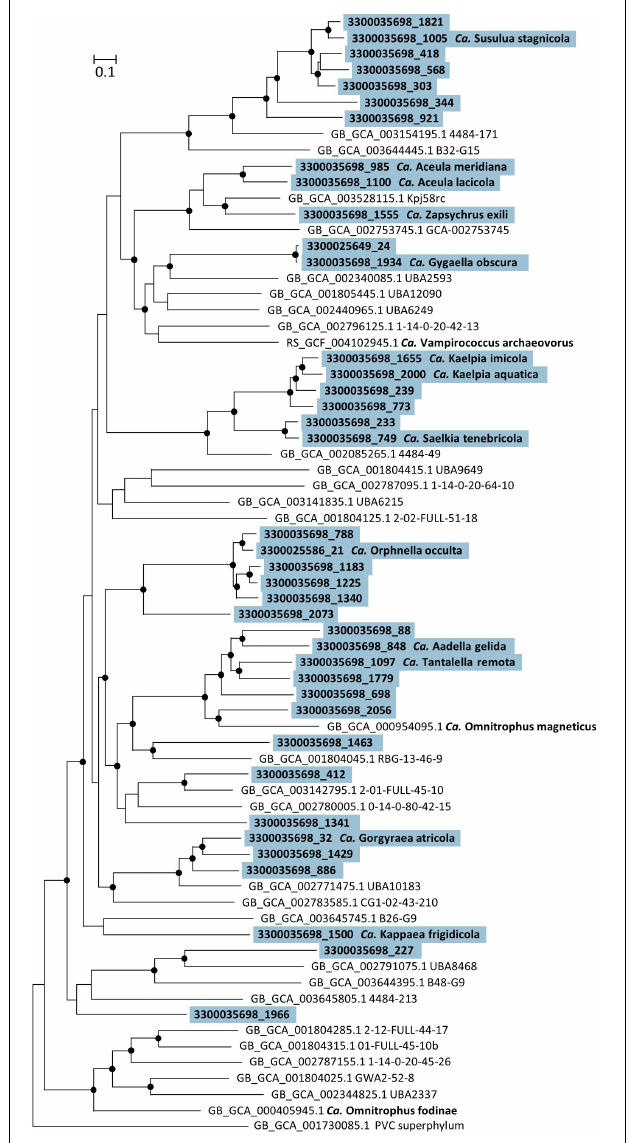
FIGURE 2 | Phylogeny of phylum Candidatus Omnitrophota. Maximum likelihood tree constructed in IQ-Tree with autoselection of the best-fit model (LG + F + I + G4) and 1,000 ultra-fast bootstraps. UFBootstraps ≥ 95% (black dot); Metagenome-assembled genomes (MAGs) featured in this study (blue) with their IMG MAG ID and proposed Candidatus genus and species names. Reference Omnitrophota MAGs are shown with their Genome Taxonomy Database (GTDB) accession and GTDB taxonomy, except for Candidatus Omnitrophus fodinae and Candidatus Omnitrophus